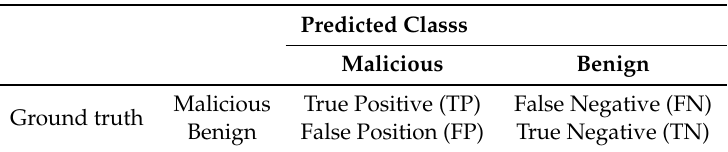
Table 4. Confusion